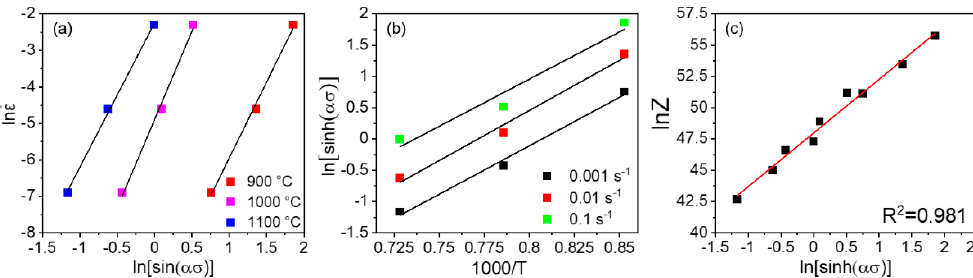
Figure 5. The relationship and linear fitting between ( a ) ln 𝜀(cid:4662) vs ln[sin( ασ )], ( b ) ln[sinh( ασ )] vs (1/T), and ( c ) lnZ vs ln[sinh( ασ )] of the (CoCrNi) 94 Ti 3 Al 3 alloy. The hot-compression was carried out at 900, 1000, and 1100 °C with a strain rate of 0.1, 0.01, and 0.001 s − 1 .